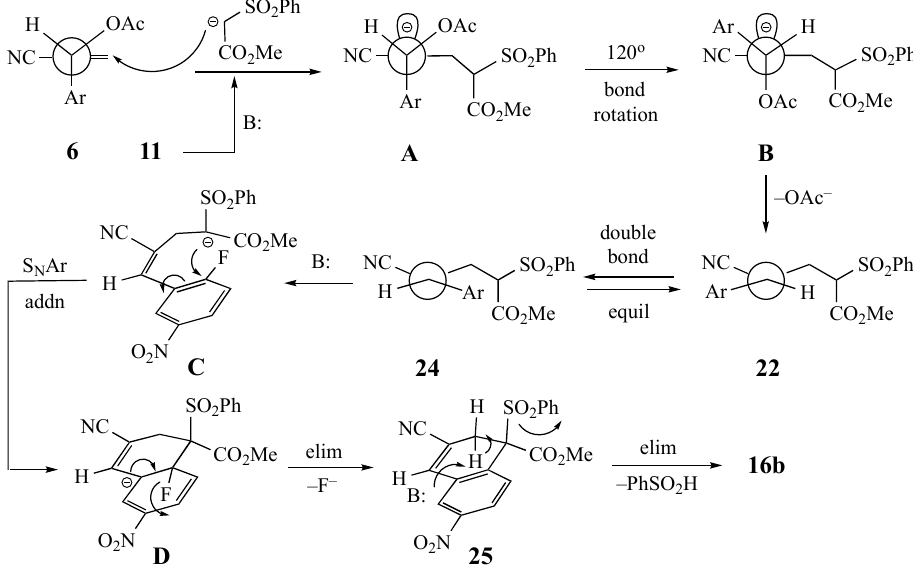
Figure 2. Conformation of an MBH alcohol with a stabilizing H ‐ bond.